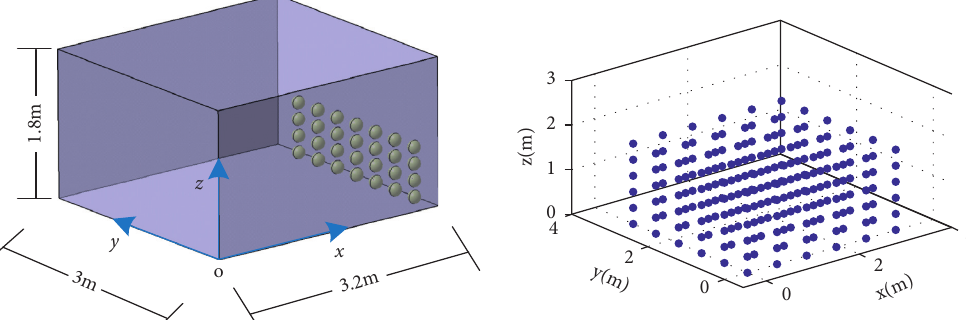
Figure 3: The enclosed room and its discrete form used in the numerical verification. The yellow dots denote the sensors.